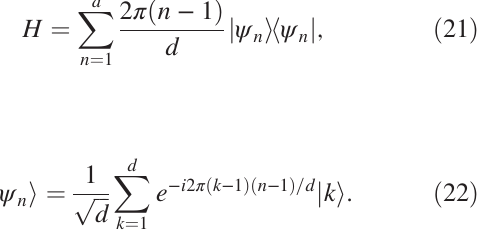
FIG. 4. Embeddability of 3 × 3 circulant matrices. Every 3 × 3 circulant matrix corresponds to a point within a half-square in the parameter space ½ a; b (cid:2) according to Eq. (17). The green petal- shaped region around the origin contains all (classically) embed- dable matrices. The set of quantum-embeddable matrices is larger and contains the orange trianglelike region of unistochastic matrices, as well as two, blue, petal-like regions corresponding to permutations of the classically embeddable